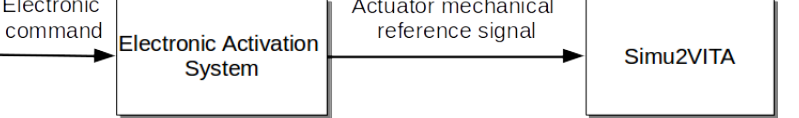
Figure 1. A simple schematic showing the logic to add some electronic activation dynamics of the actuators when using